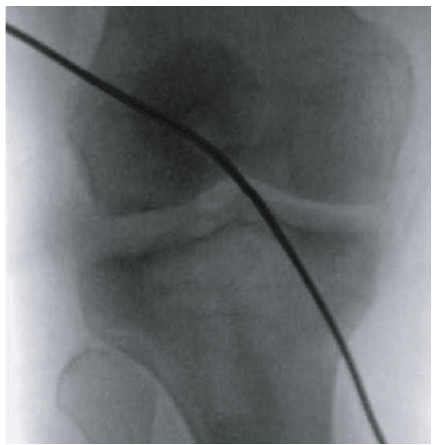
Figure 7: Intra-operative anterior-posterior fl uoroscopic image con fi rming placement of the fl exible guide pin below the physis.